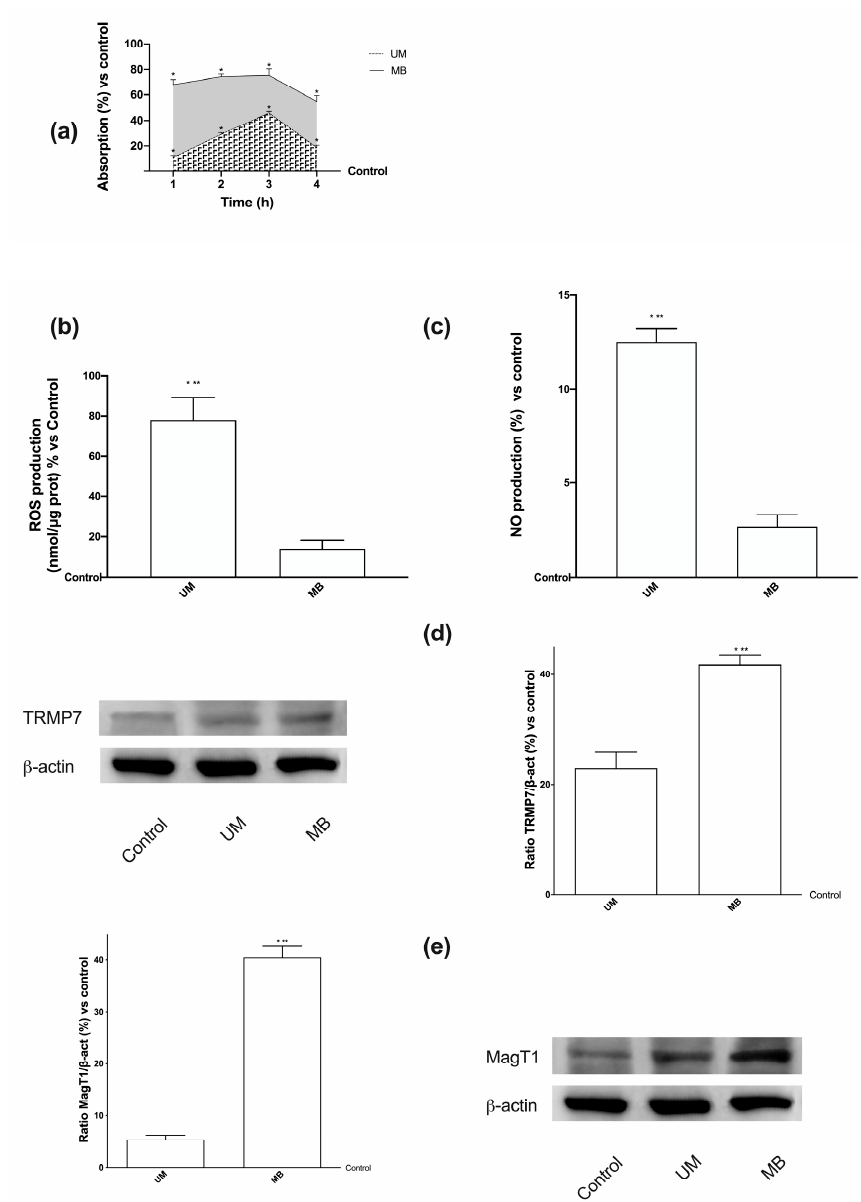
Figure 1. Magnesium and magnesium transport quantification, and balance of reactive oxygen species (ROS) / nitric oxide (NO) produced on Caco-2 cells. ( a ) Total Mg absorbed measured at the basolateral level on transwell during time (ranging from 1 h to 4 h). Data are means ± SD (%) compared to control values (line 0%) of four independent experiments produced in triplicate. * p < 0.05 vs. control; p < 0.05 between sucrosomial magnesium (UM) and magnesium-bu ff ered bisglycinate chelate (MB) at the same time point across all time points. ( b ) ROS analysis measured at 3 h expressed as means ± SD (%) of cytochrome C reduced / µ g of protein normalized to control (line 0%) of five independent experiments produced in triplicate. * p < 0.05 vs. control; ** p < 0.05 vs. MB. ( c ) NO production measured at 3 h normalized to control (line 0%) and expressed as means ± SD (%) of five independent experiments produced in triplicate. * p < 0.05 vs. control; ** p < 0.05 vs. MB. The images reported in ( d ) and ( e ) are examples of each protein of five independent experiments reproduced in triplicate. ( d,e ) Densitometric analysis of TRPM7 and MagT1 expression obtained in whole Caco-2 lysates at 3 h of stimulation. Data are expressed as means ± SD (%) of five independent experiments normalized and verified on β -actin detection. * p < 0.05 vs. control; ** p < 0.05 vs. UM.